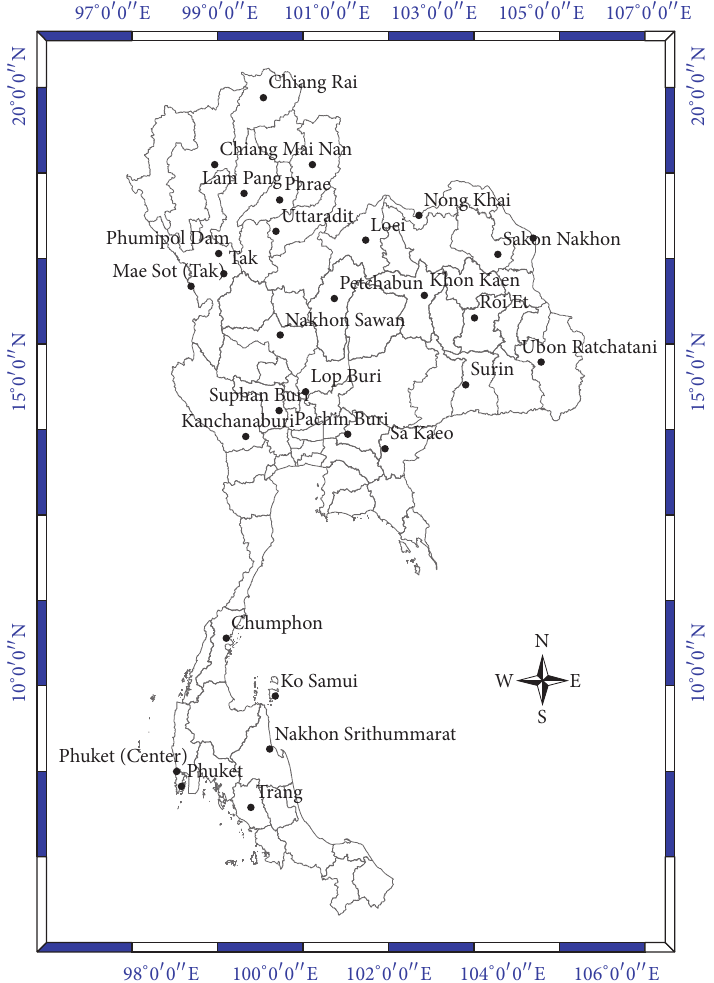
Figure 2: Location map of the study area in